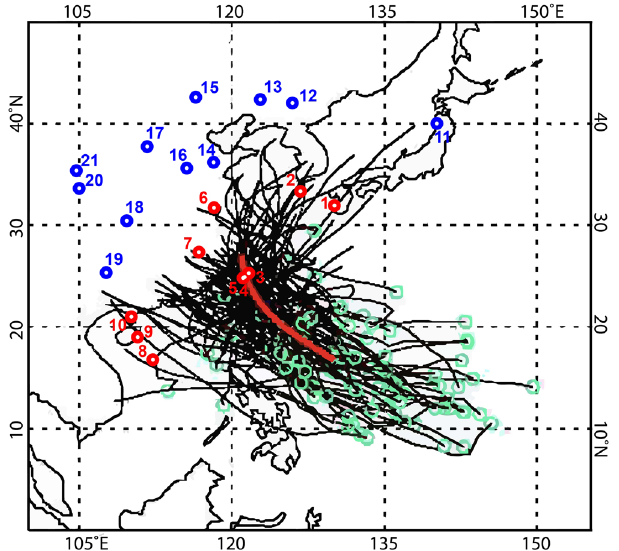
Figure 5. Locations of paleohydroclimate records examined in this study. Coastal sites showing the dry MCA/ wet LIA pattern are indicated by red numbers (1–10) while other sites are by blue numbers (11–21). Dr. Seo, K.H. provided the background map with tropical cyclone tracks, which was created using an Interactive Data Language program (IDL 8.1; www.harrisgeospatial.com). These tracks belong to the second cluster according to his classification of tropical cyclones between 1979 and 2013 69 . The black lines and red thick line indicate the individual tropical cyclone tracks and the vector weight, respectively. The green open circles show the tropical cyclone genesis positions. The frequency of tropical cyclones in this cluster is significantly negatively correlated with ETP (the NINO3 region) SSTs during El Niño conditions 69 .